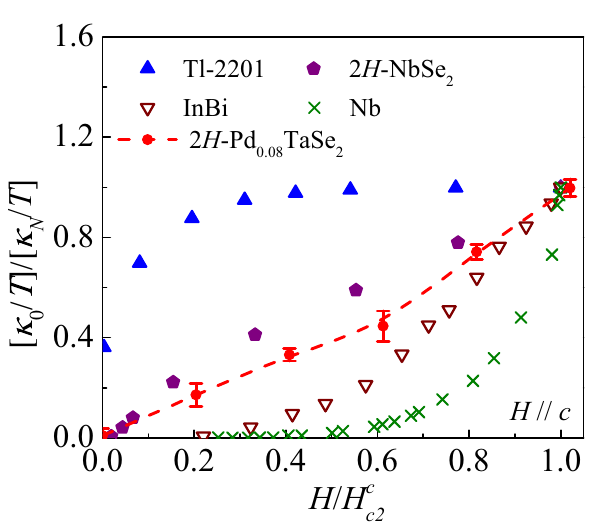
aT n 1 with n κ 0 / T 2 to the data at µ 0 H = 0 T and 2.5 T − = = + c T reaches to c 2 ( 0 ) = 2.45 T , κ 0 / L 2 cm (blue 0 /ρ N = 163 µ W/ K =